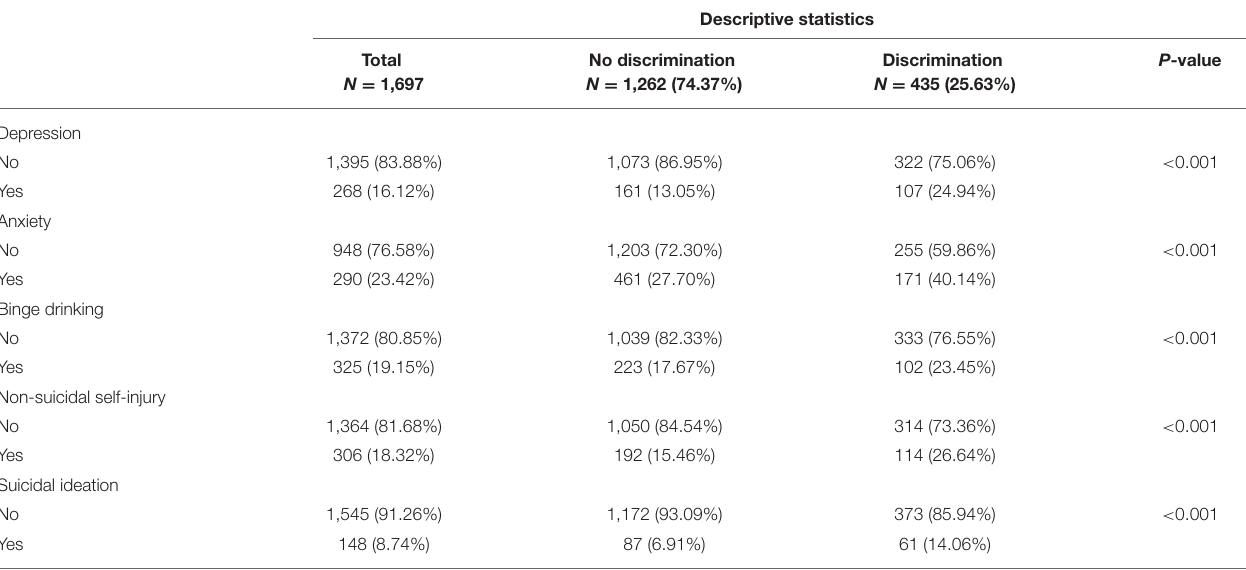
TABLE 1 | Associations between COVID-19 related racial/ethnic discrimination and mental health outcomes among American/Pacific Islander students from the Healthy Minds Study, September–December 2020.